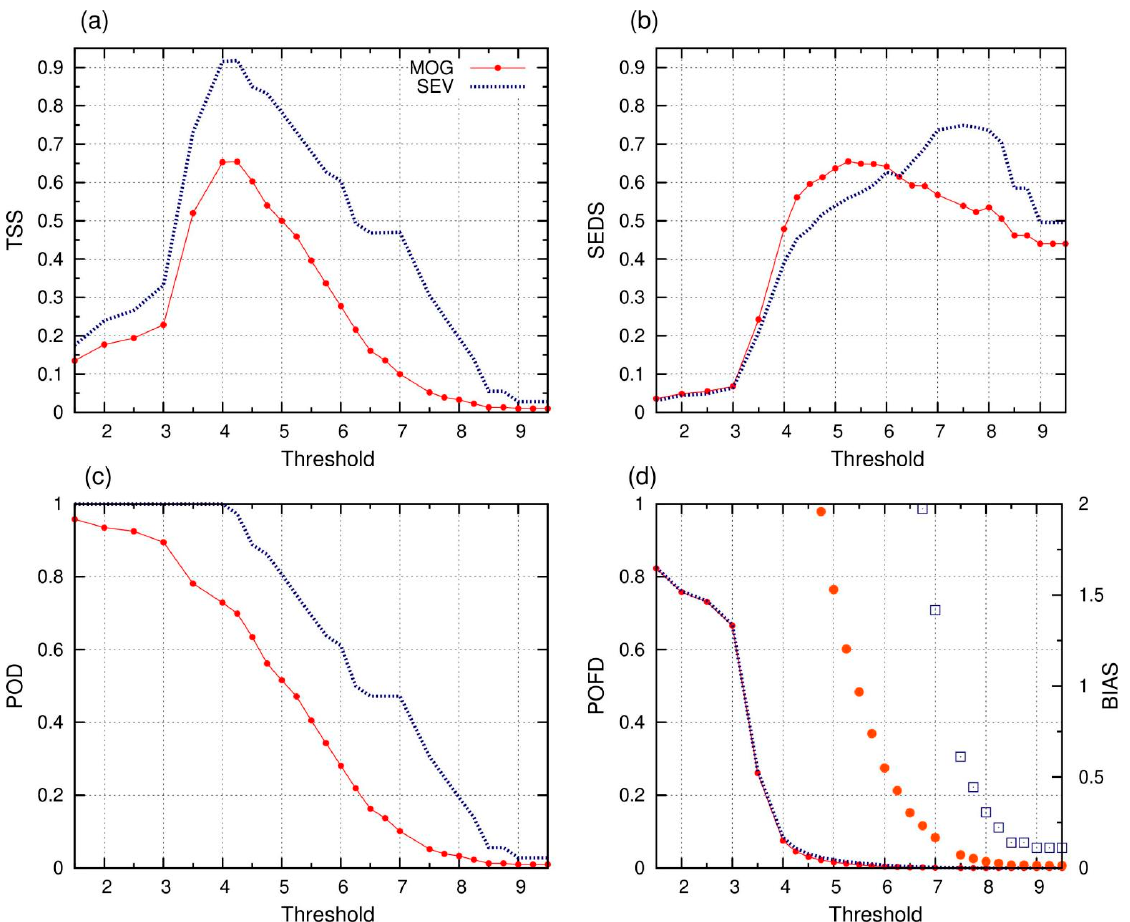
Figure 11. Skill of TURB IPMA regarding the ability to predict MOG and SEV turbulence. ( a ) TSS, ( b ) SEDS, ( c ) POD, and ( d ) POFD for different thresholds. In ( d ) BIAS should read on the right y-axis for MOG (circles) and SEV (open squares) turbulence.